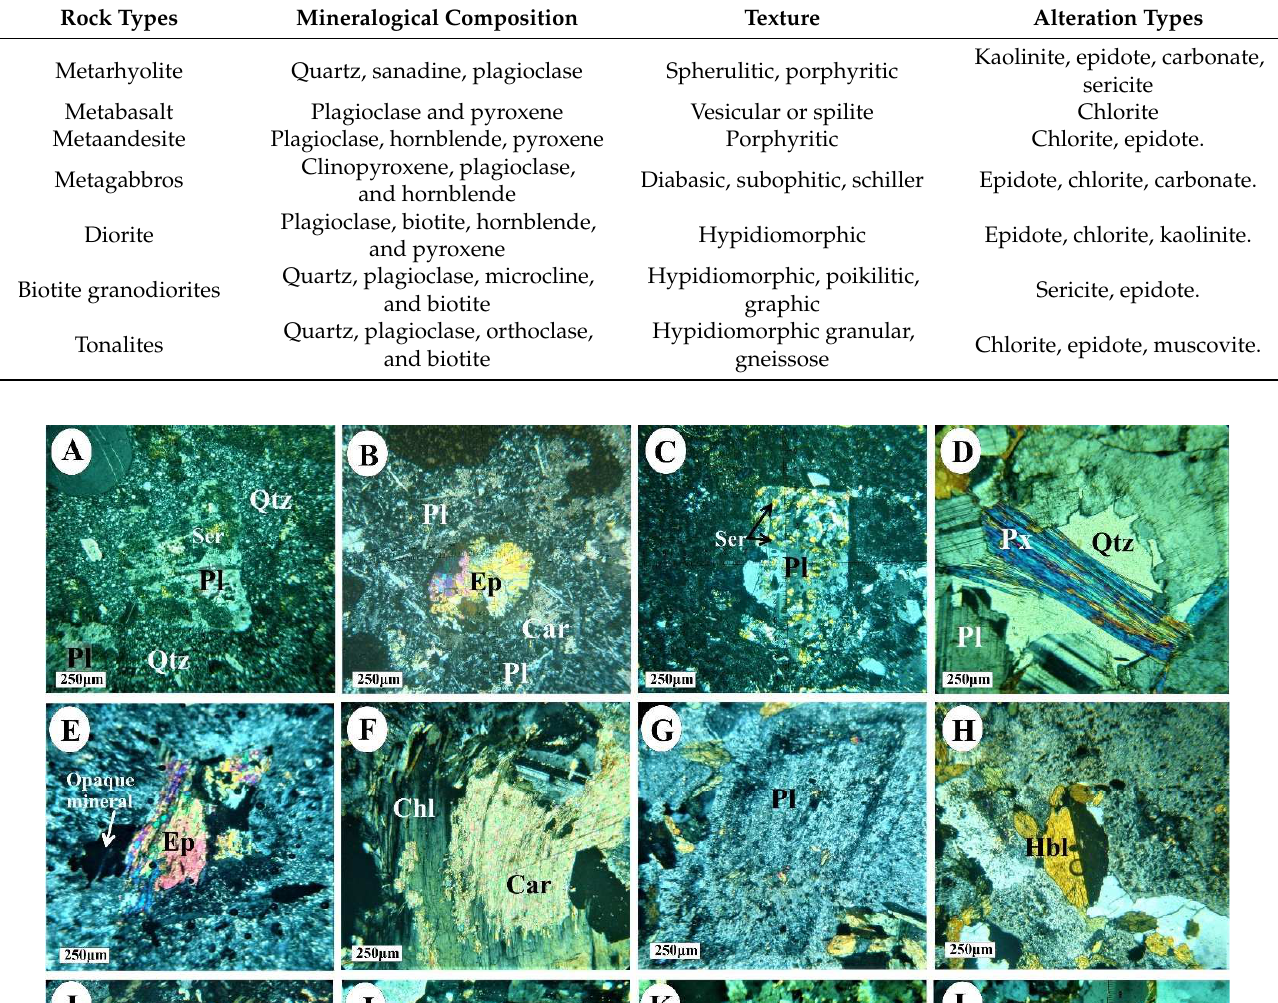
Table 5. Summary of the petrographic descriptions of different rock types in the study area.